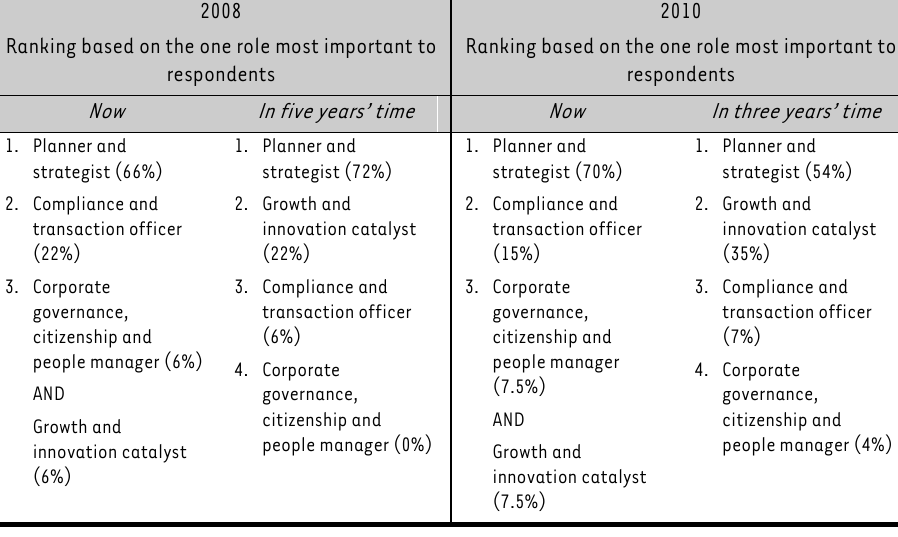
TABLE 15: Comparison of one role most important now and in the future 2008